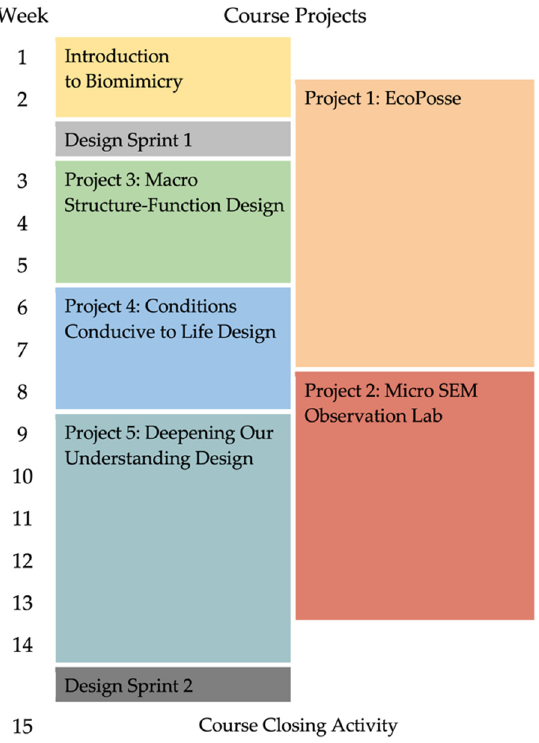
Figure 2. Course project schedule. See Appendix A for project